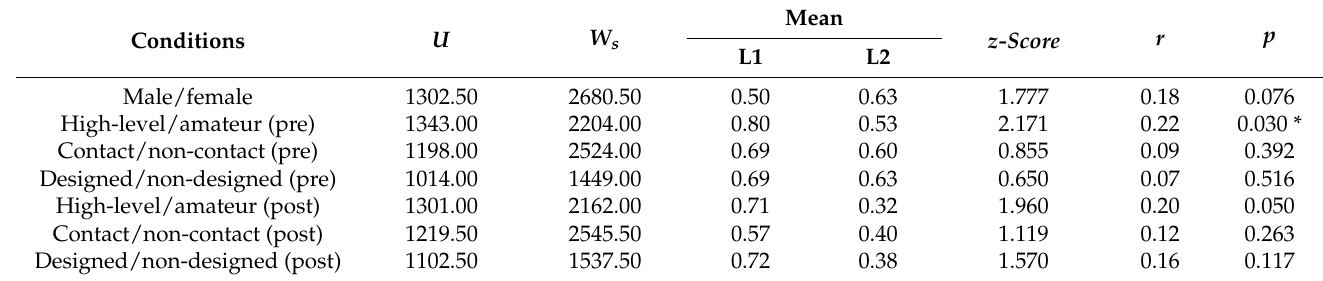
Table 3. Comparison of IR differences between variables with two levels (BL and AL).